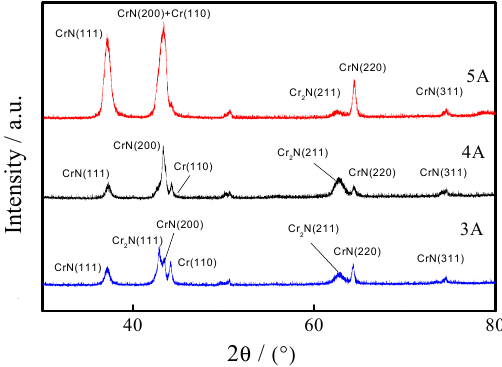
Figure 2. XRD patterns of the CrN x coating under different filament currents.